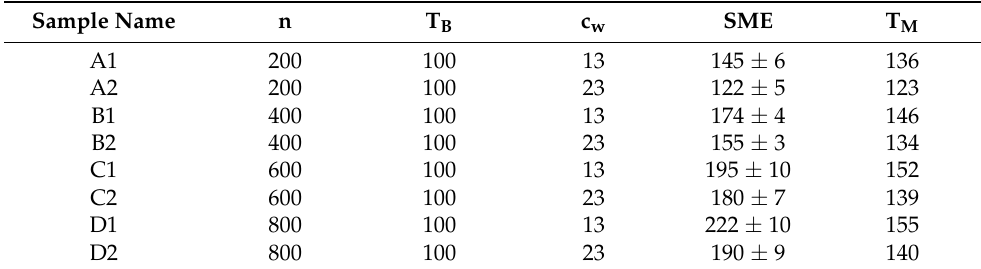
Table 1. Experiments performed. Extrusion parameters (n, screw speed (min − 1 ); T B , barrel tem- perature ( ◦ C); c w , water content (%); SME, specific mechanical energy (Whkg − 1 ); T M , material temperature ( ◦ C); total mass flow for all trials was 10 kgh − 1